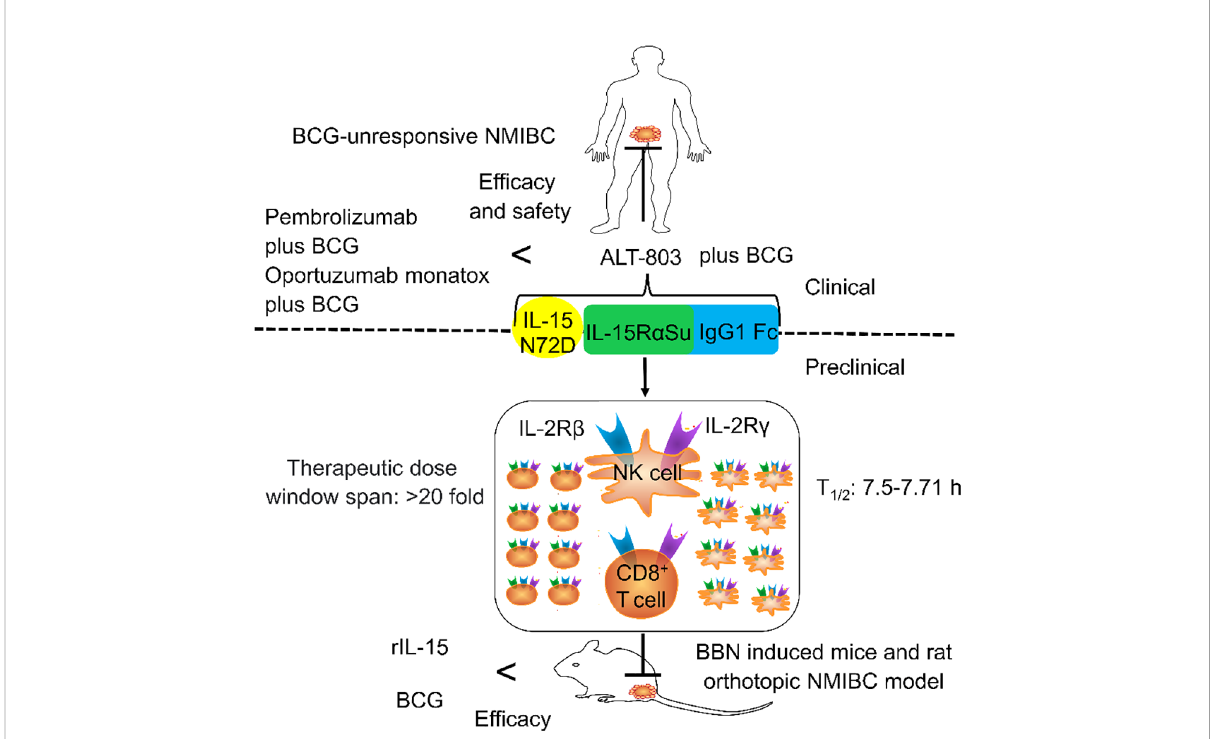
FIGURE 2 The general structure of ALT-803 and its role in non-muscle-invasive bladder cancer (NMIBC). ALT-803 contains IL-15 N72D, IL-15R a Su, and IgG1 Fc. IL-15 N72D promotes the proliferation and activation of NK and T cells by enhancing the activity of binding to IL-2R b . IL-15R a Su can selectively transexpress the IL-2R bg chain of NK and CD8+ T cells without expanding Tregs. IgG1 Fc not only prolonged the half-life but also increased the circulation and distribution of lymphocytes. The preclinical ef fi cacy and safety of ALT-803 were higher than that of Bacillus Calmette – Gue ́ rin (BCG) and rIL-15. The clinical ef fi cacy and the safety of ALT-803 plus BCG for the treatment of patients with BCG- unresponsive NMIBC were higher than that of pembrolizumab plus BCG and oportuzumab monatox plus